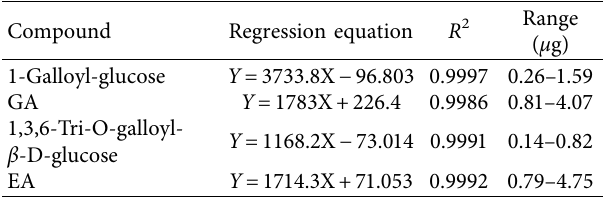
Table 1: Linear equation, R 2 , and range of 1-galloyl-glucose, GA, TGG, and EA for quantitative